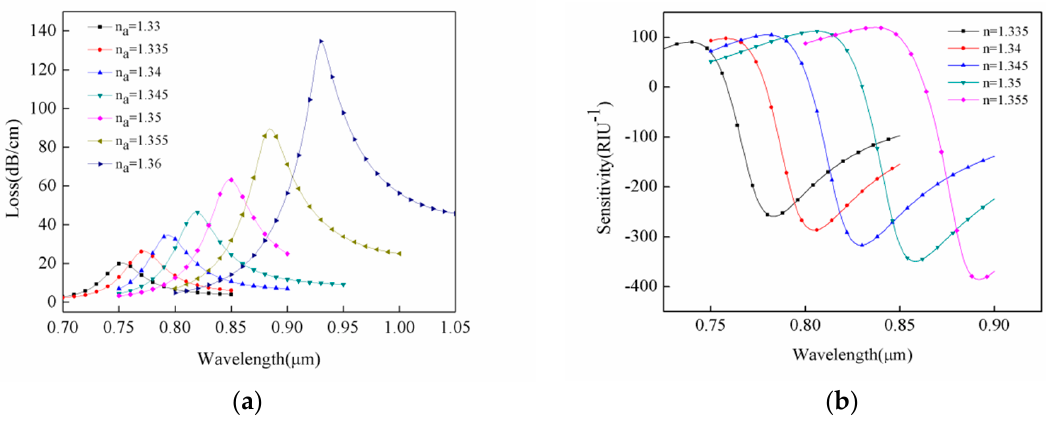
Figure 8. ( a ) Changes in loss peak with different analyte refractive indexes. ( b ) Changes in amplitude sensitivity at different analyte refractive indexes. Condition: r a = 0.6 μ m, r b = 0.3 μ m, and r g = 0.2 μ m.